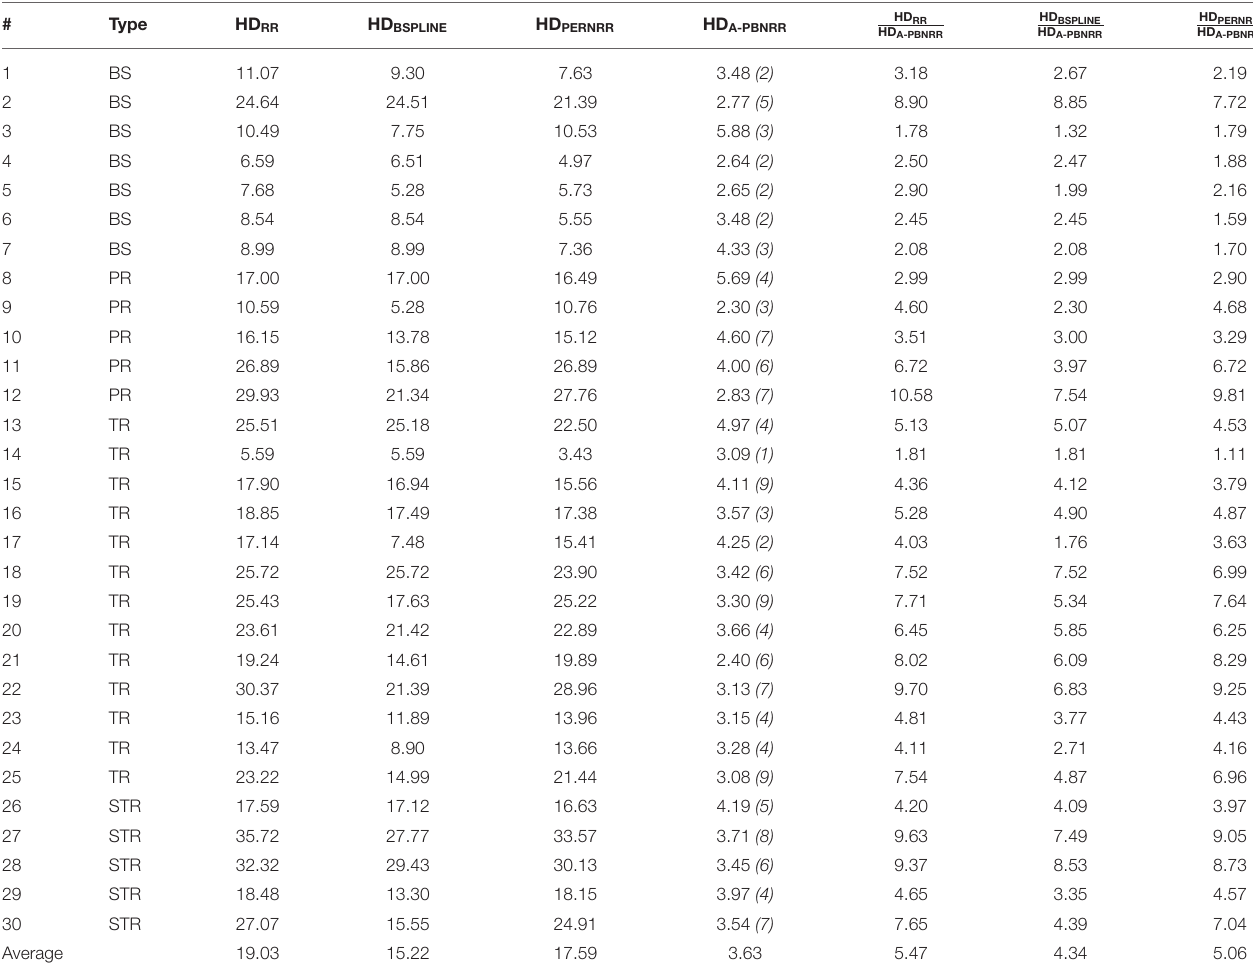
TABLE 4 | Quantitative registration results using the HD